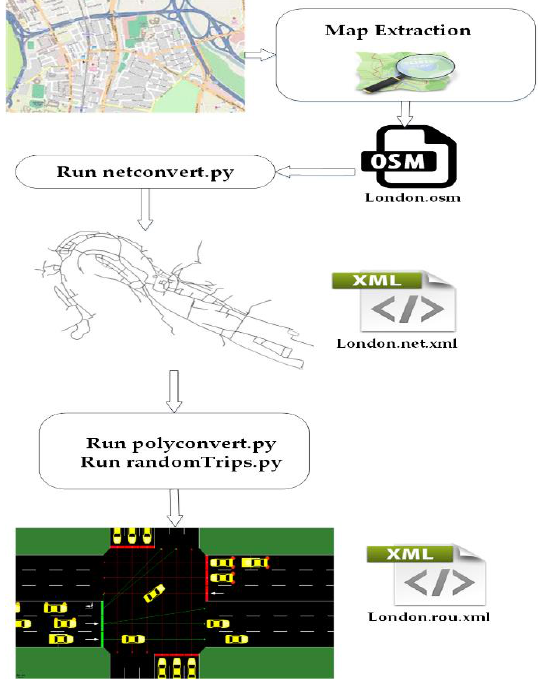
Figure 5. Trip generation using SUMO and OSM.